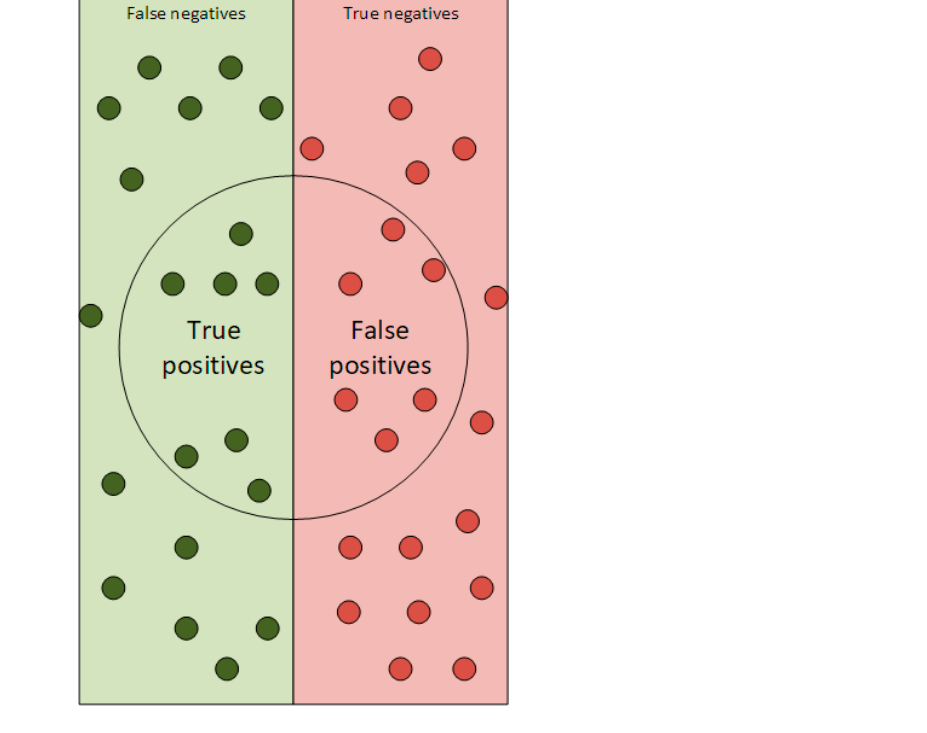
Table 1. Overview of Area Under the ROC (AUC) and Precision metrics (train and test data) for different algorithms. Proximity-Based LinearModel